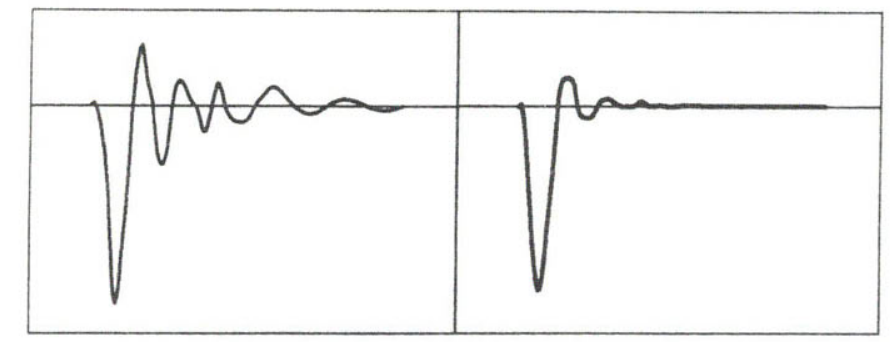
Fig. 3. The shape of output pulses of the PMT Hamamatsu R647-04: (a) - using the HV divider Hamamatsu E849-35 and (b) - using the HV divider D303 of the Vilnius